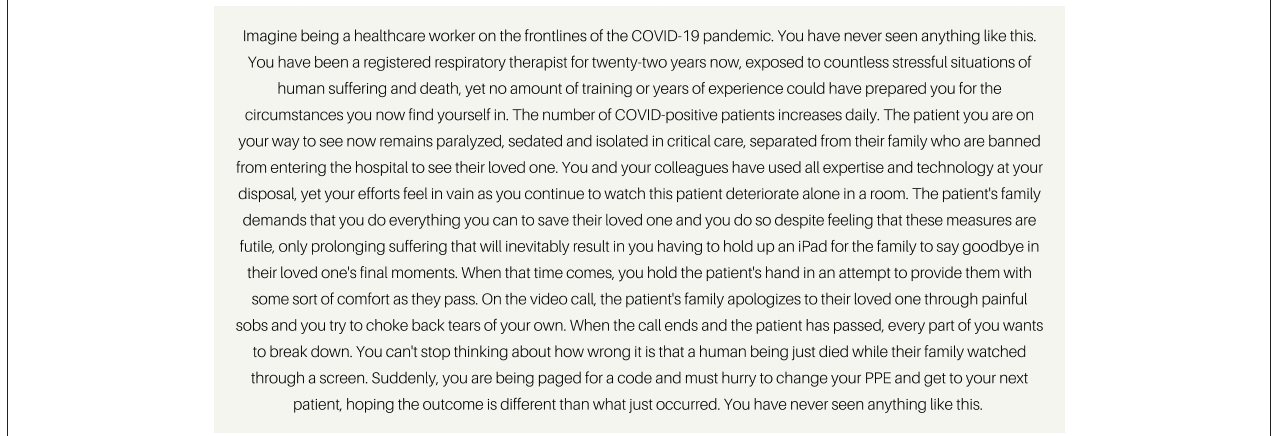
FIGURE 1 | In an ongoing study in our research group, healthcare workers from across Canada have described various events which may be experienced as morally injurious. This vignette provides a summary of the types of events we have heard about from Canadian respiratory therapists early in the Spring of 2021. Participants recounted instances of having to perform care that was perceived to be futile, feeling helpless when caring for critically-ill COVID-positive patients and being at the beside of dying COVID-positive patients in place of their family members, who were prohibited from entering the hospital due to COVID restrictions. Additional stressors compacting upon these potentially morally injurious events included having no time to process events, rushing to change PPE and a high patient